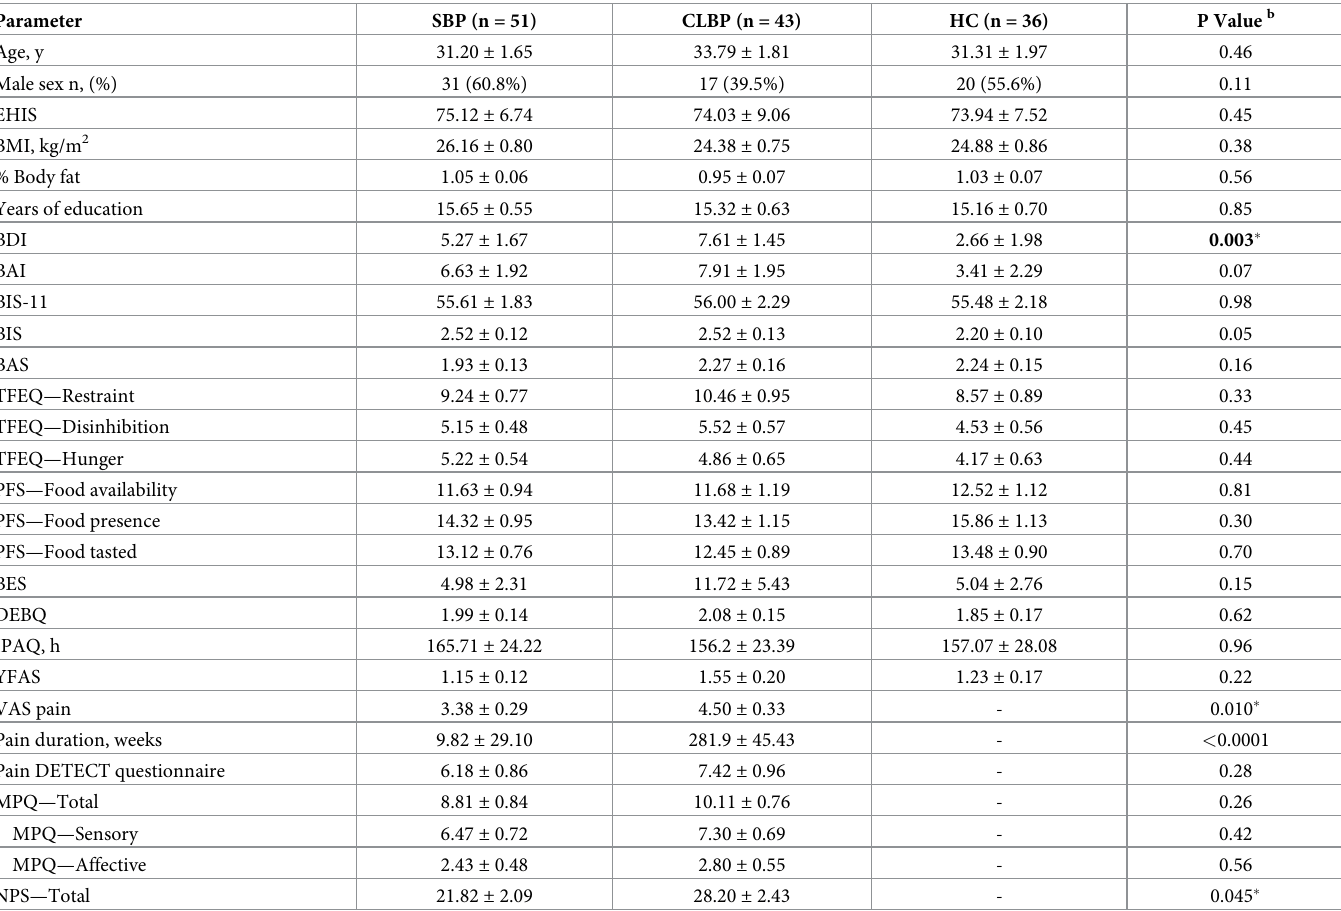
Table 1. Demographic and clinical characteristics of all groups baseline a